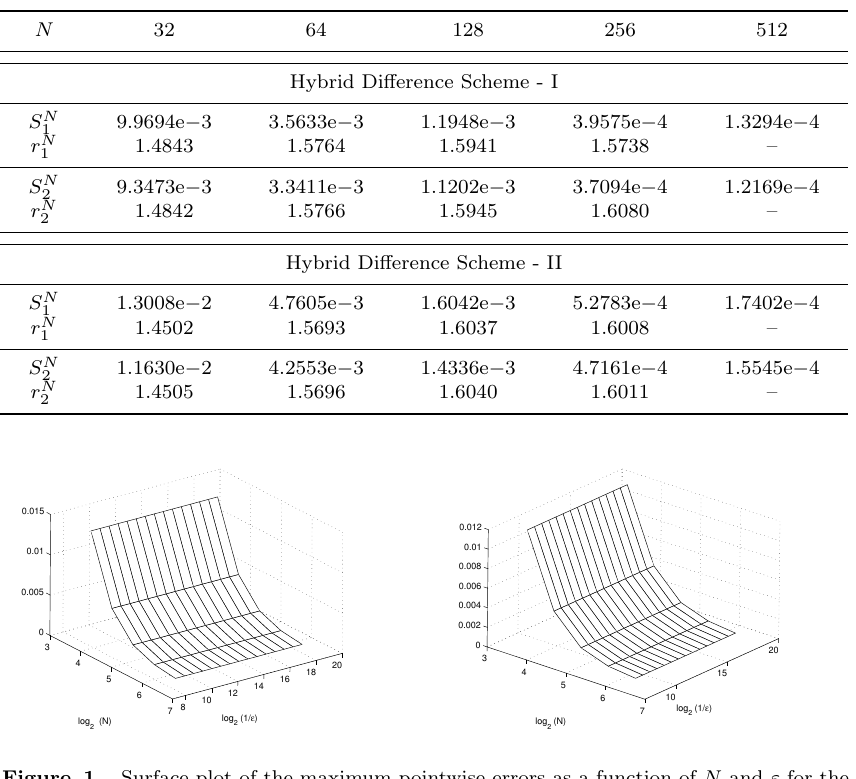
Table 1. Values of S N